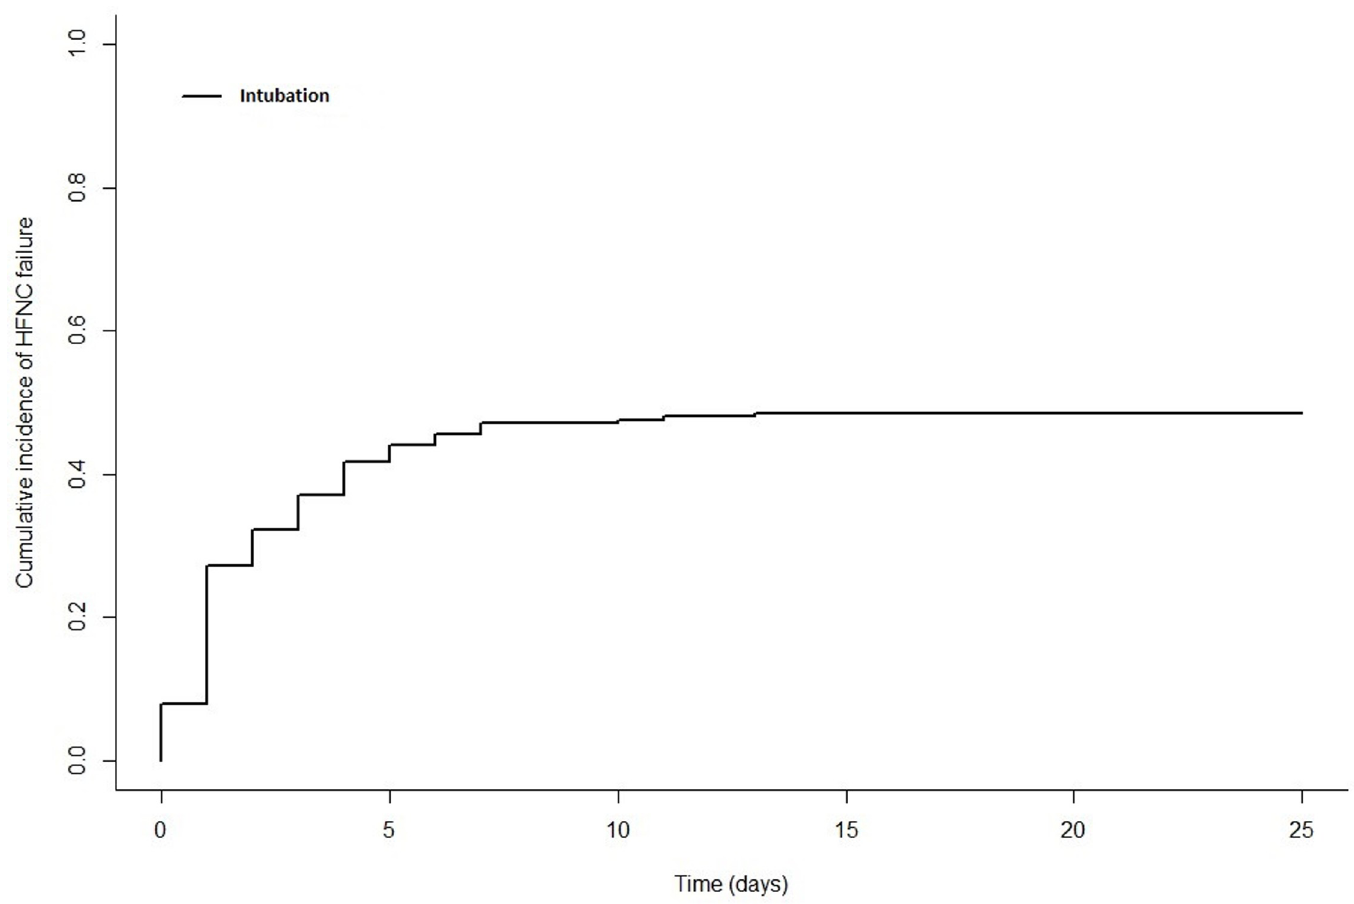
Fig 3. Cumulative incidence of intubation in days.